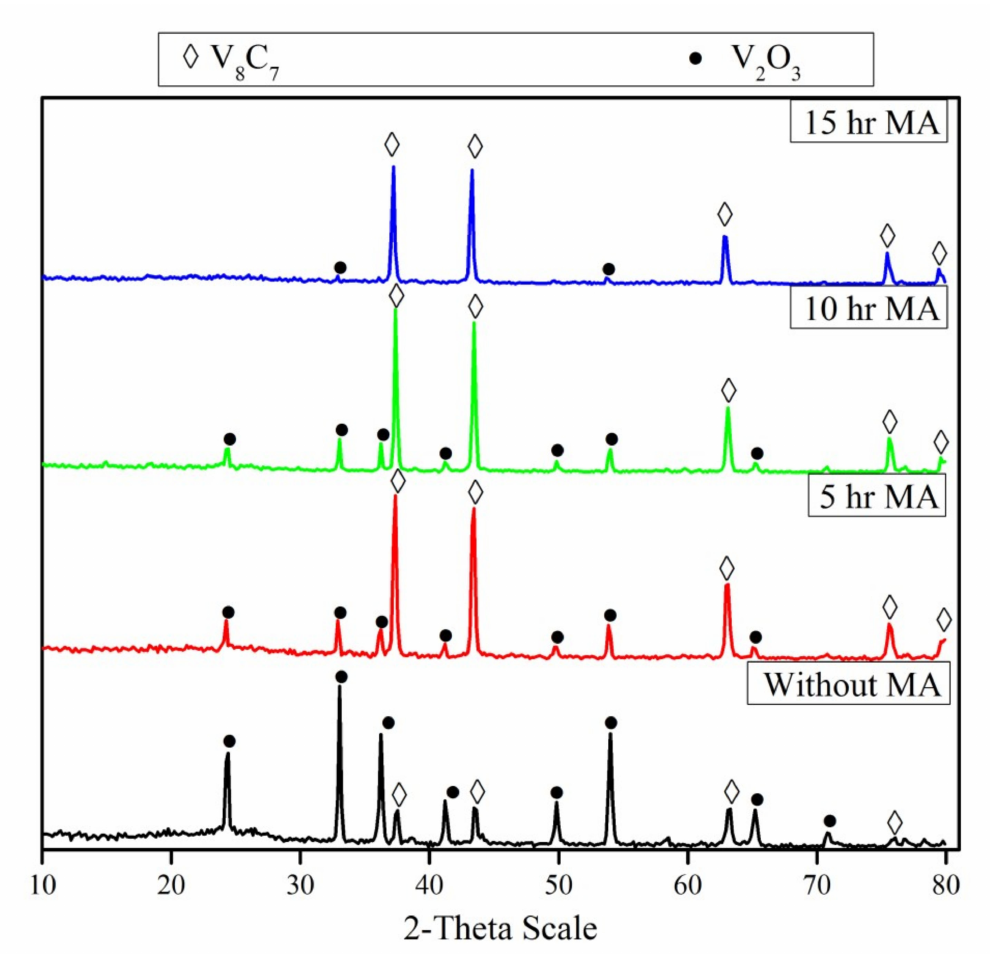
Figure 5. XRD patterns of reduction products of un-milled and milled V 2 O 5 -C mixture at di ff erent periods (5–15 h) after reduction at 1050 ◦ C for 1